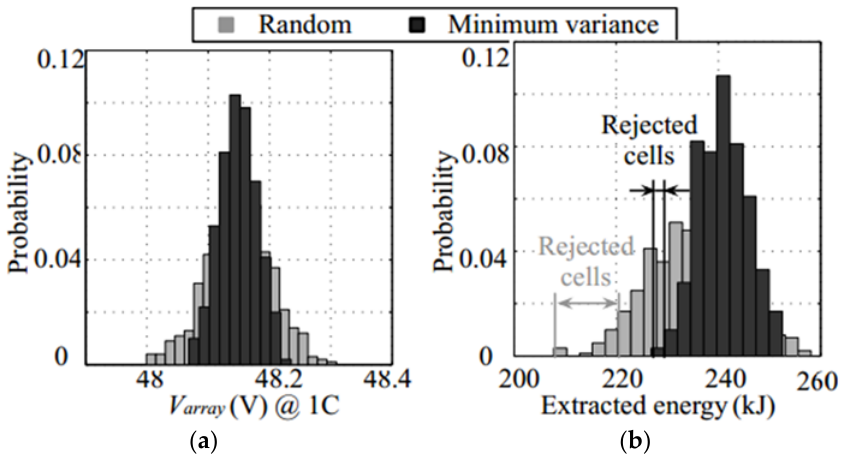
Figure 2. Comparison of ( a ) estimated array voltage ( V array ) with 1C discharging current and ( b ) extracted energy from sample battery arrays formed by random selection and variance minimization. From [38].